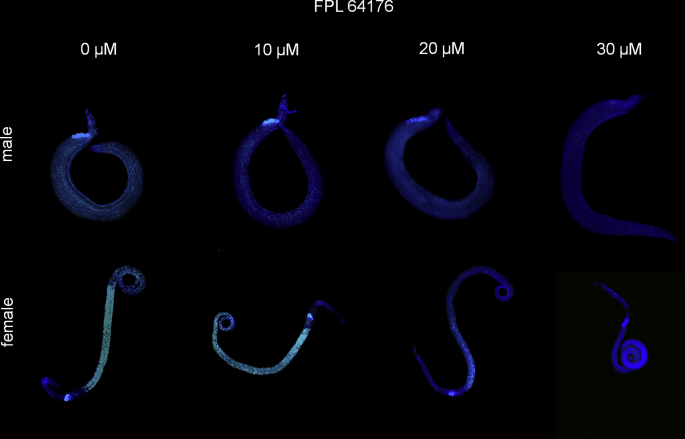
Effect of FPL-64176 on schistosome mitotic activity at 37°C. Worms treated with FPL-64176 (0, 10, 20 and 30 μM) and EdU (10 μM) at 37 °C / 5% CO2 for 12 h. EdU incorporation = Green. Hoechst DNA counterstain = Blue.